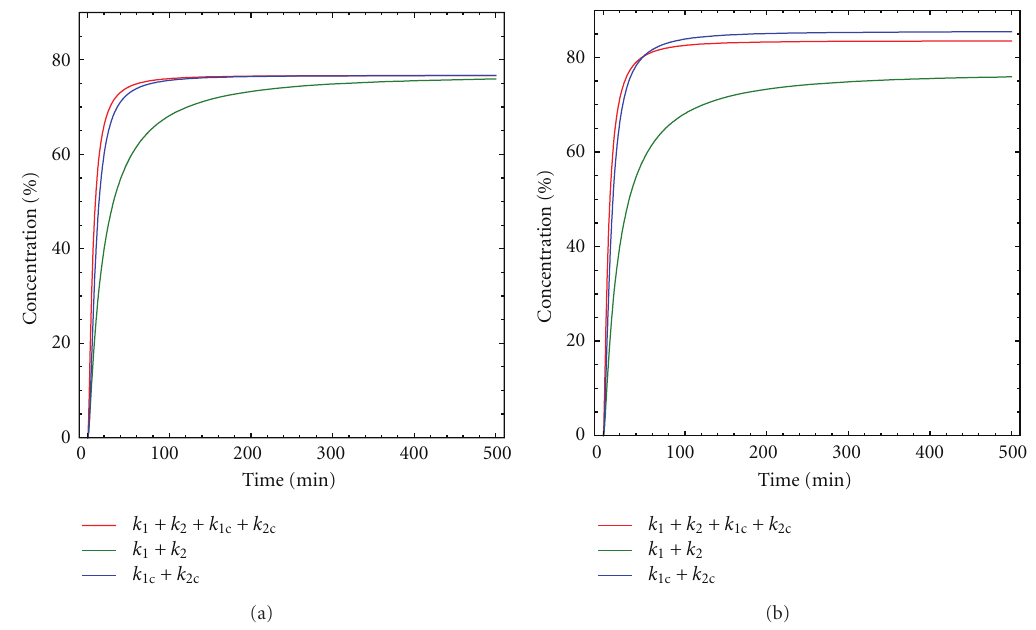
Figure 14: Concentration macrocycle D versus time for kinetic model 8. [A] 0 = [B] 0 = 0.005 M, [Br − ] 0 = 0.0025 M, k 1 = 10M − 1 min − 1 , k 1 c = 4000 M − 2 min − 1 , k = 0.5min − 1 , (a) k = 200 M − 1 min − 1 , and (b) k = 400M − 1 min − 1 . 2 2 c 2 c